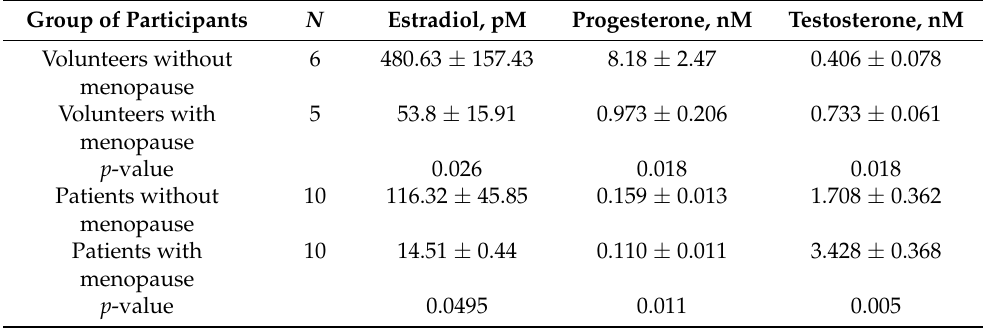
Figure 2. Venn diagram comparing DEPs in the donated skin samples as assessed by LC/MS – MS analysis. ( A ) Paired comparison of the samples obtained from lesional and uninvolved skin of the same psoriasis patients (n = 5) and skin of healthy volunteers (n = 5). ( B ) Analysis of gender-specific changes in protein expression. Samples of male (n = 3) and female (n = 2) psoriatic skin were compared to the skin of healthy volunteers (n = 5). The numbers indicated in the diagram are the numbers of DEPs in the compared groups of samples ( p < 0.05). DEPs chosen for PO analysis are encircled. The data were compared using the Mann – Whitney U test.